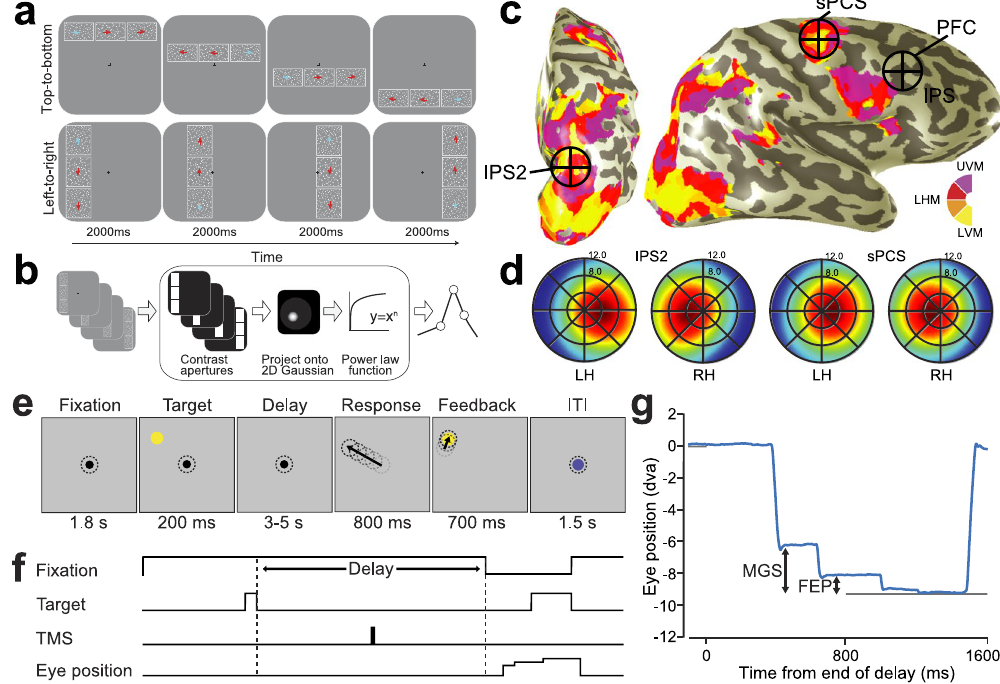
Figure 1. Experimental procedures. ( a ) Discrimination task used for topographic mapping. Subjects fixated centrally while covertly attending to a bar consisting of three apertures of moving dots that swept across the screen. Subjects pressed a button to indicate which flanking aperture (left or right; above or below) contained dots moving in the same direction as the center sample aperture. Staircases adjusted dot motion coherence in the flanking apertures to constantly tax attention. White outlines around each aperture were not visible to the subject, but are shown here for clarity. ( b ) Nonlinear population receptive field (pRF) modeling schematic. Stimulus sequences from the discrimination task were converted into 2D binary contrast apertures and projected onto an isotropic 2D Gaussian that represented a predicted pRF. Static nonlinearity was applied to account for compressive spatial summation. ( c ) Stimulation sites projected onto the inflated cortical surface of a sample subject. Color indicates the best-fit phase angle by the pRF model. sPCS and IPS2 stimulation sites were localized by our mapping procedure, and dorsolateral PFC stimulation targets were defined by individual subject anatomical landmarks. ( d ) Visual field map coverage in IPS2 and sPCS. While visual field maps in both regions primarily represent the contralateral hemifield, they also represent portions of the ipsilateral hemifield. ( e ) Memory-guided saccade task. While fixating, subjects maintained the position of a brief visual target over a memory delay, and then made a saccade to the remembered target. The correct target location was again presented for feedback. Dotted circles depict gaze, but were not visible to subjects. ( f ) Temporal structure of the experimental task and application of TMS. In order to disrupt the maintenance of information, we applied a short burst of patterned TMS to IPS2, sPCS, or dorsolateral PFC during the middle of the delay period on each trial. ( g ) An example horizontal eye position trace shows two distinct types of memory error relative to the true target location: the endpoint of an initial memory-guided saccade (MGS), and the final eye position (FEP) following quick corrective saccades (in this example only one) prior to the re-presentation of the target feedback (gray